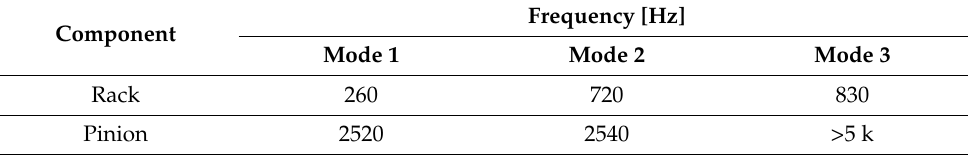
Table 2. Experimental modal modes.